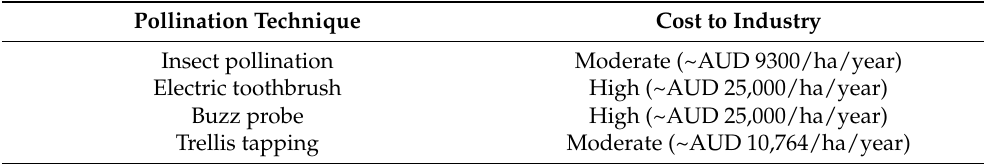
as air velocity increases [26]. Flowers being tested had a natural frequency (22 Hz) in their test range of 5–60 Hz, however this was specific to variety and the prevailing